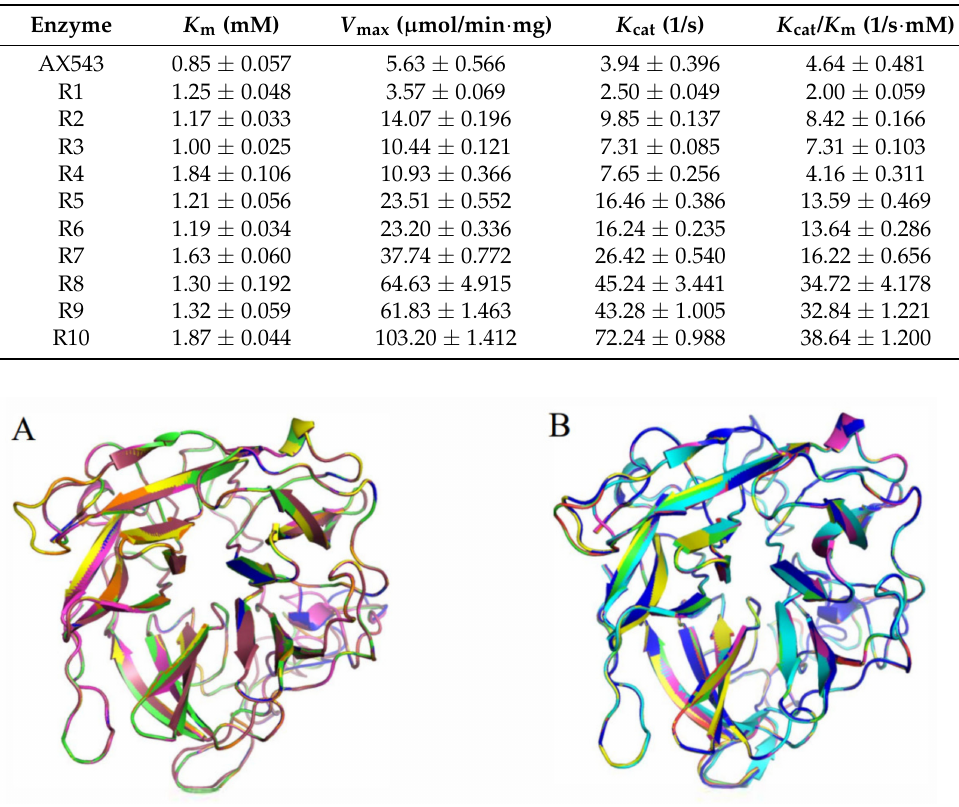
Figure 11. The comparison of protein structures between the variants and xylosidase AX543 and Xyl43A. ( A ) R1 (orange), R2 (green), R3 (brown), R4 (pink), R5 (yellow), and AX543 (blue); ( B ) R6 (light blue), R7 (yellow), R8 (navy blue), R9 (green), R10 (pink), and Xyl43A (red). Table 5. RMSD values between the protein structures of variants and wide type AX543 and